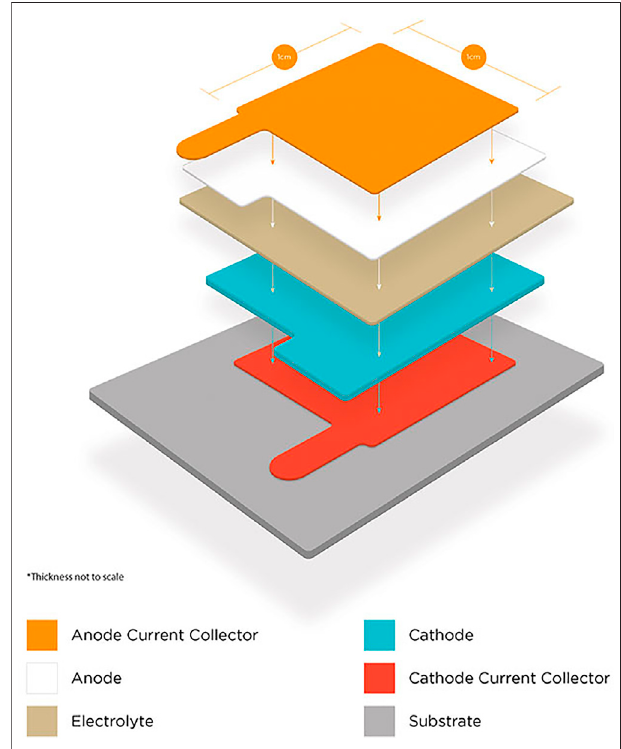
FIGURE1| Cellcon fi gurationofASTBscombinedwithPVDmethods. © Ilika